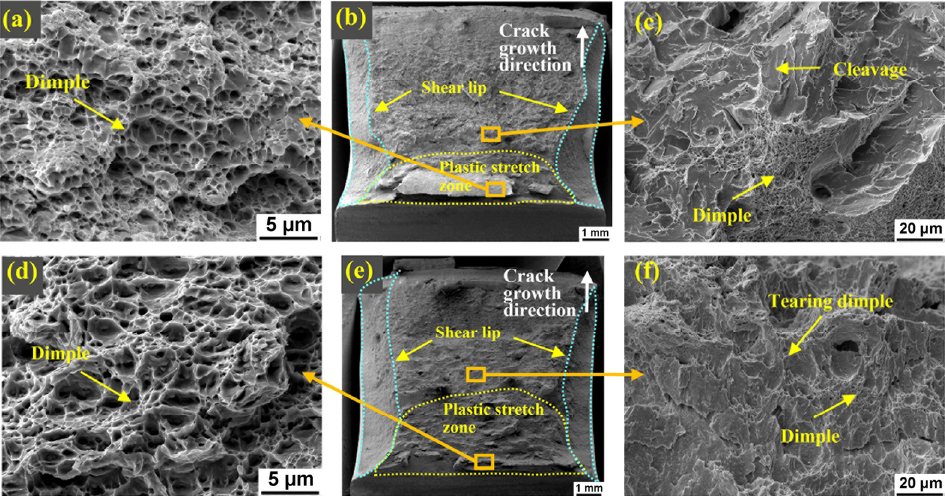
Figure 9. The impact fracture morphology of the HAZs: ( a – c ) the turbine part (156 J); ( d – f ) the compressor part (177 J).